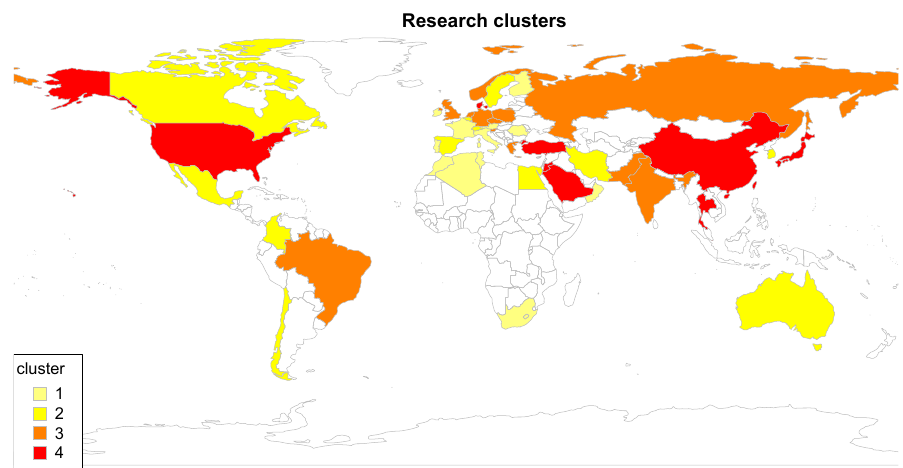
Figure 14. Cross-Country Cooperations during 2008–2016.